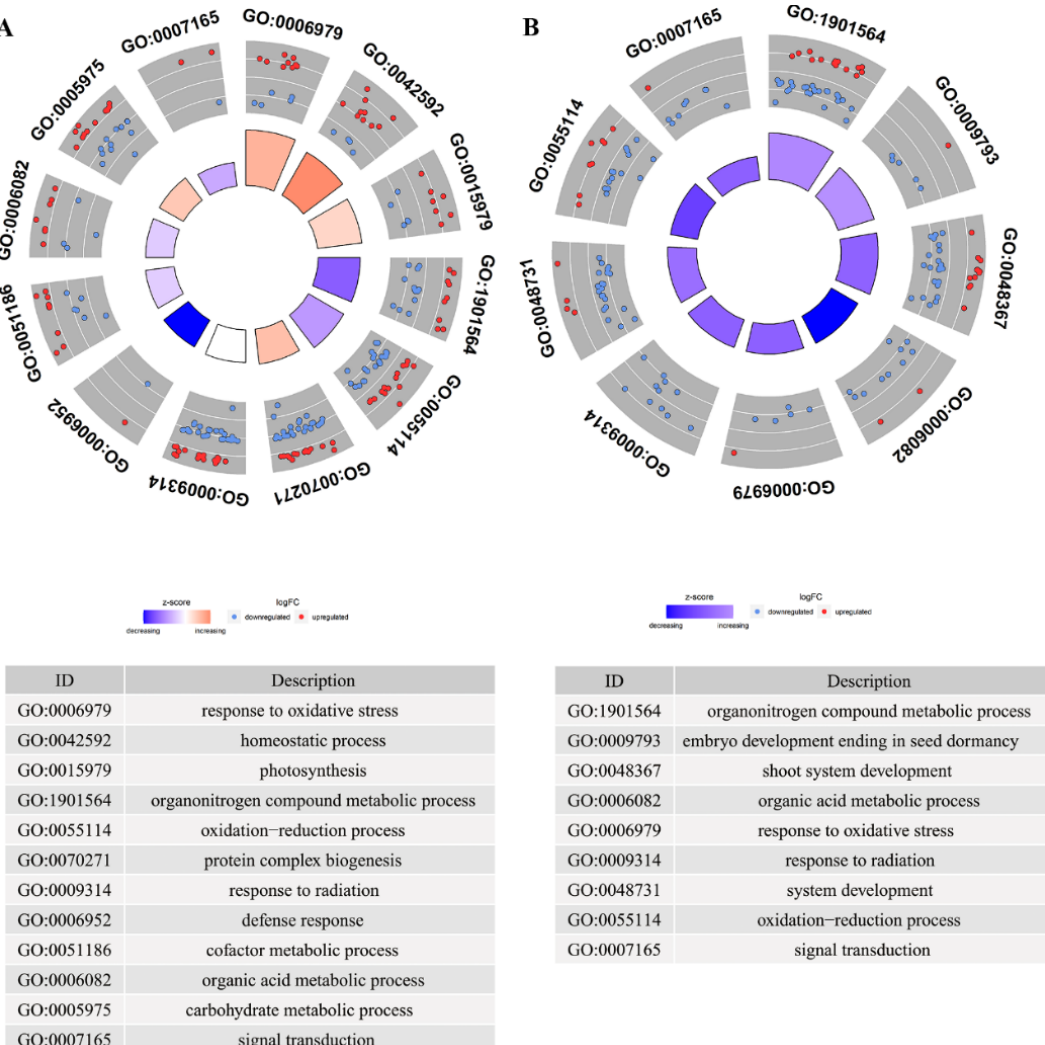
Figure 3. The circle diagram shows the biological process of the significant impact of space flight stress memory on offspring rice. Dots indicate DAPs, red indicates upregulated proteins, and blue indicates downregulated proteins. ( A ) represents the different metabolites at the TLS; ( B ) represents the DAPs at the TS; TLS and TS stand for three ‐ leaf stage and tillering stage, respectively.